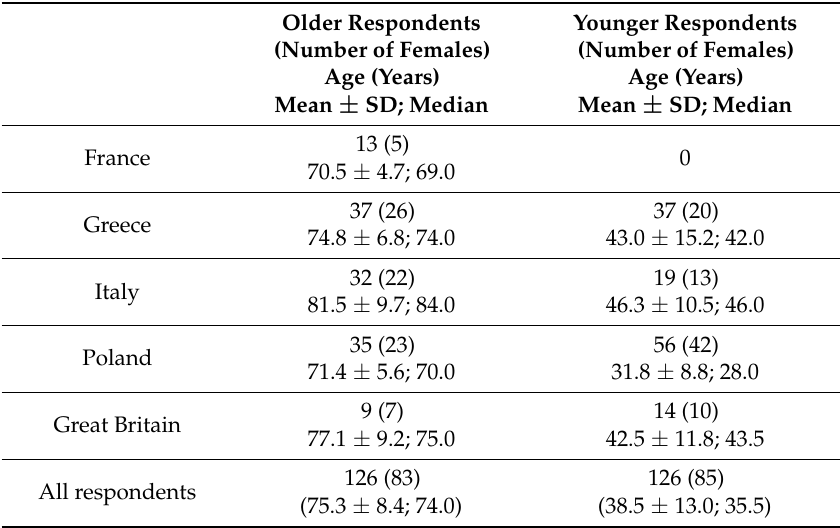
Table 1. Characteristics of the studied